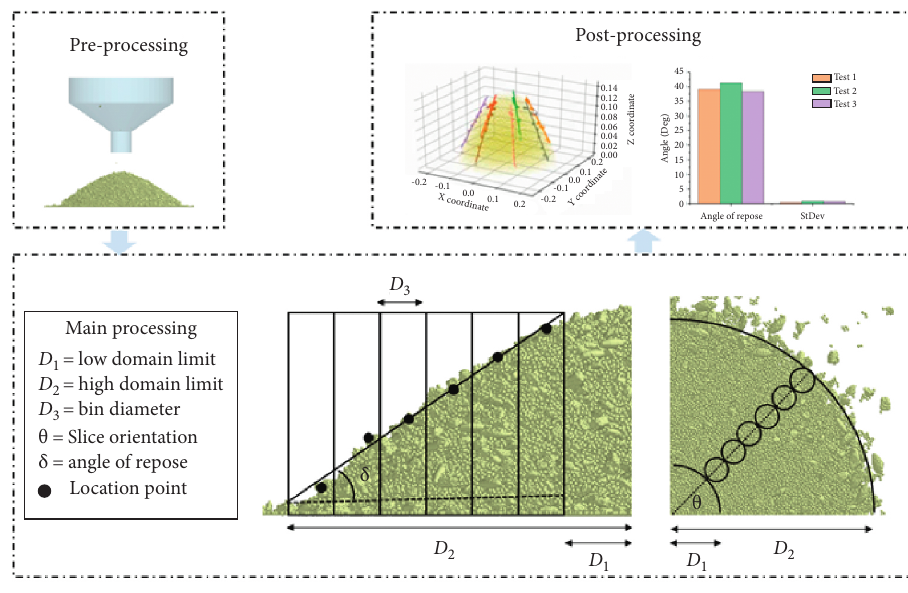
Figure 3: Flowchart of the data processing